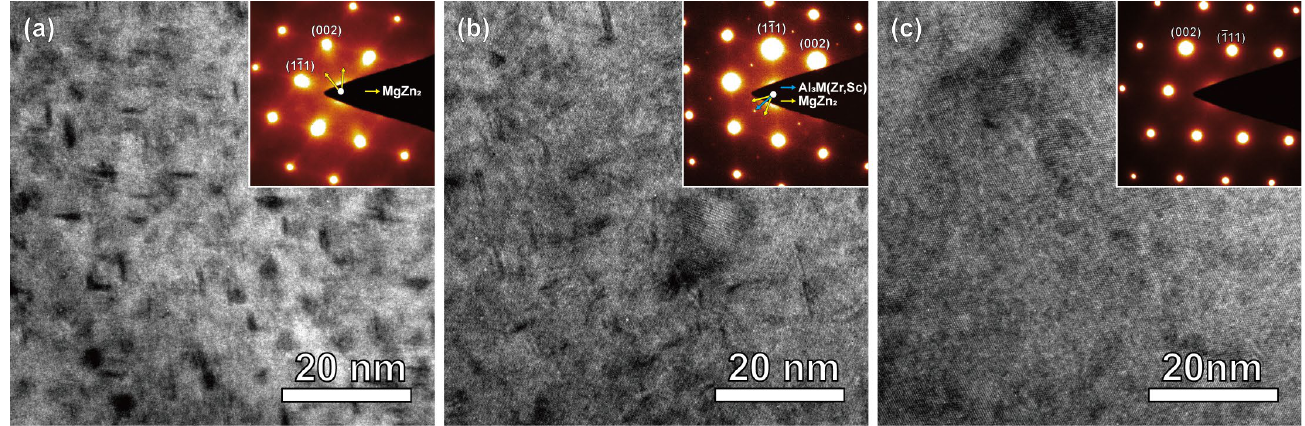
Figure 4. Bright-field images and corresponding electron diffraction patterns recorded from ( a ) Al7050, ( b ) Al7050-Sc, and ( c ) Al7050-Ag.